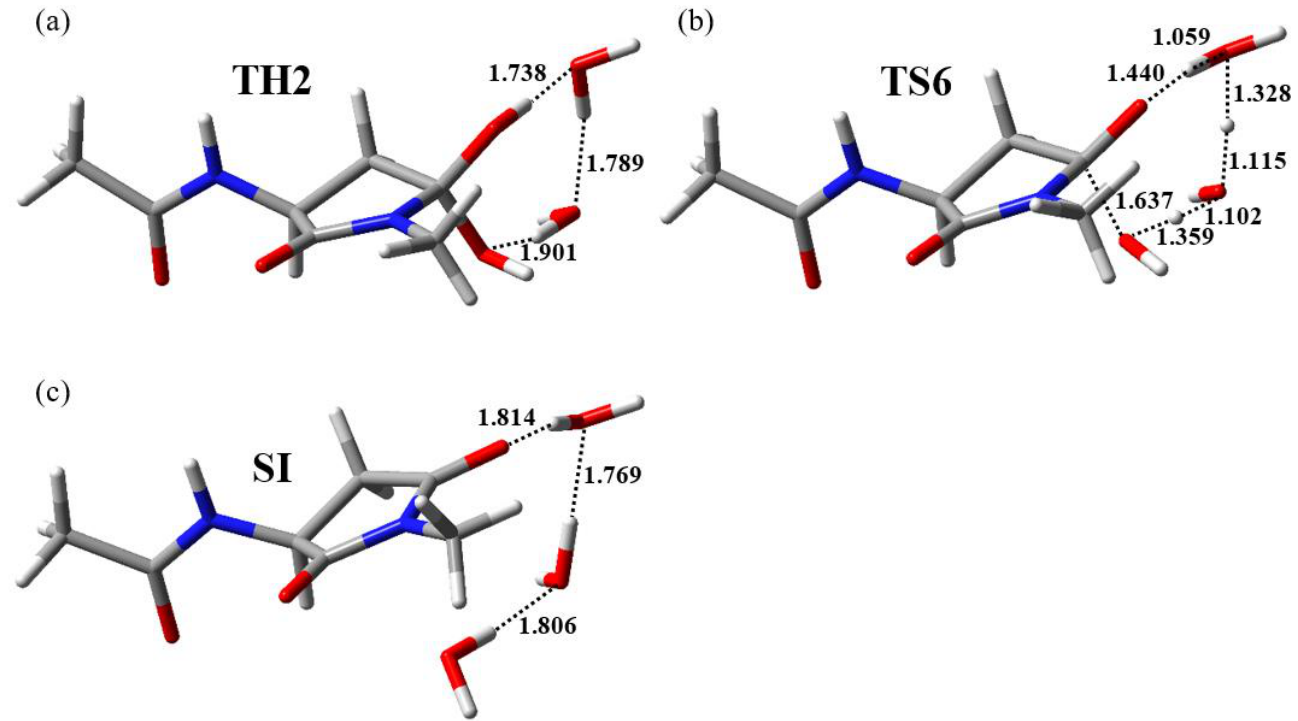
Figure 5. Optimized geometries of ( a ) TH2 ( φ = −114°, ψ = −141°, χ 1 = 150°), ( b ) TS6 ( φ = −114°, ψ = −141°, χ 1 = 149°), and ( c ) SI ( φ = −115°, ψ = −140°, χ 1 = 140°). Selected interatomic distances are presented in angstroms (Å ). Carbon, hydrogen, nitrogen, and oxygen atoms are illustrated in gray, white, blue, and red, respectively.